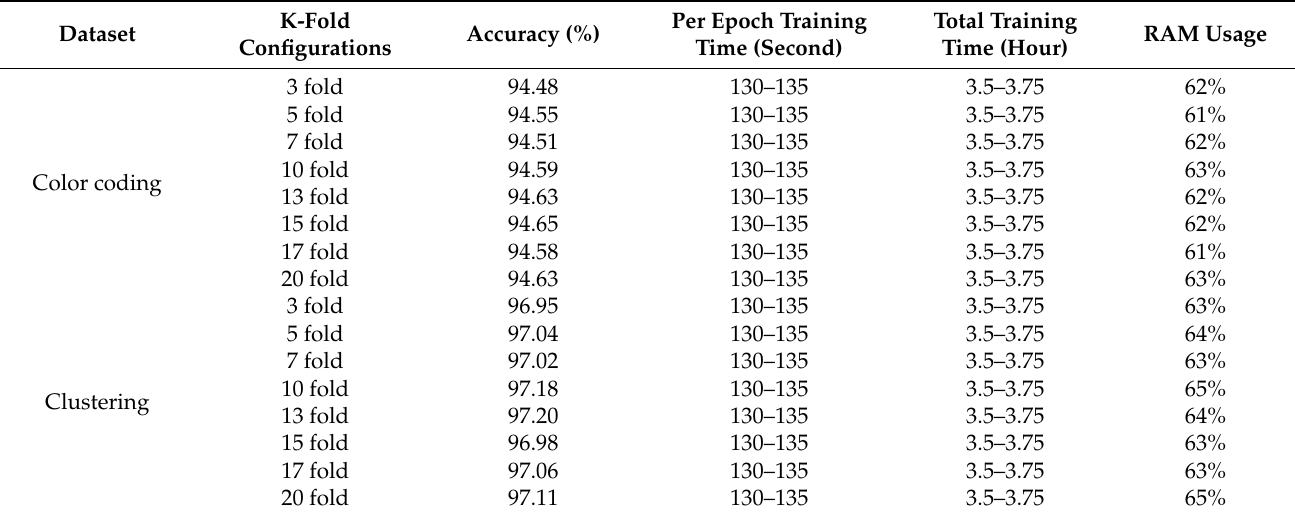
Table 8. Stability of the proposed model in terms of